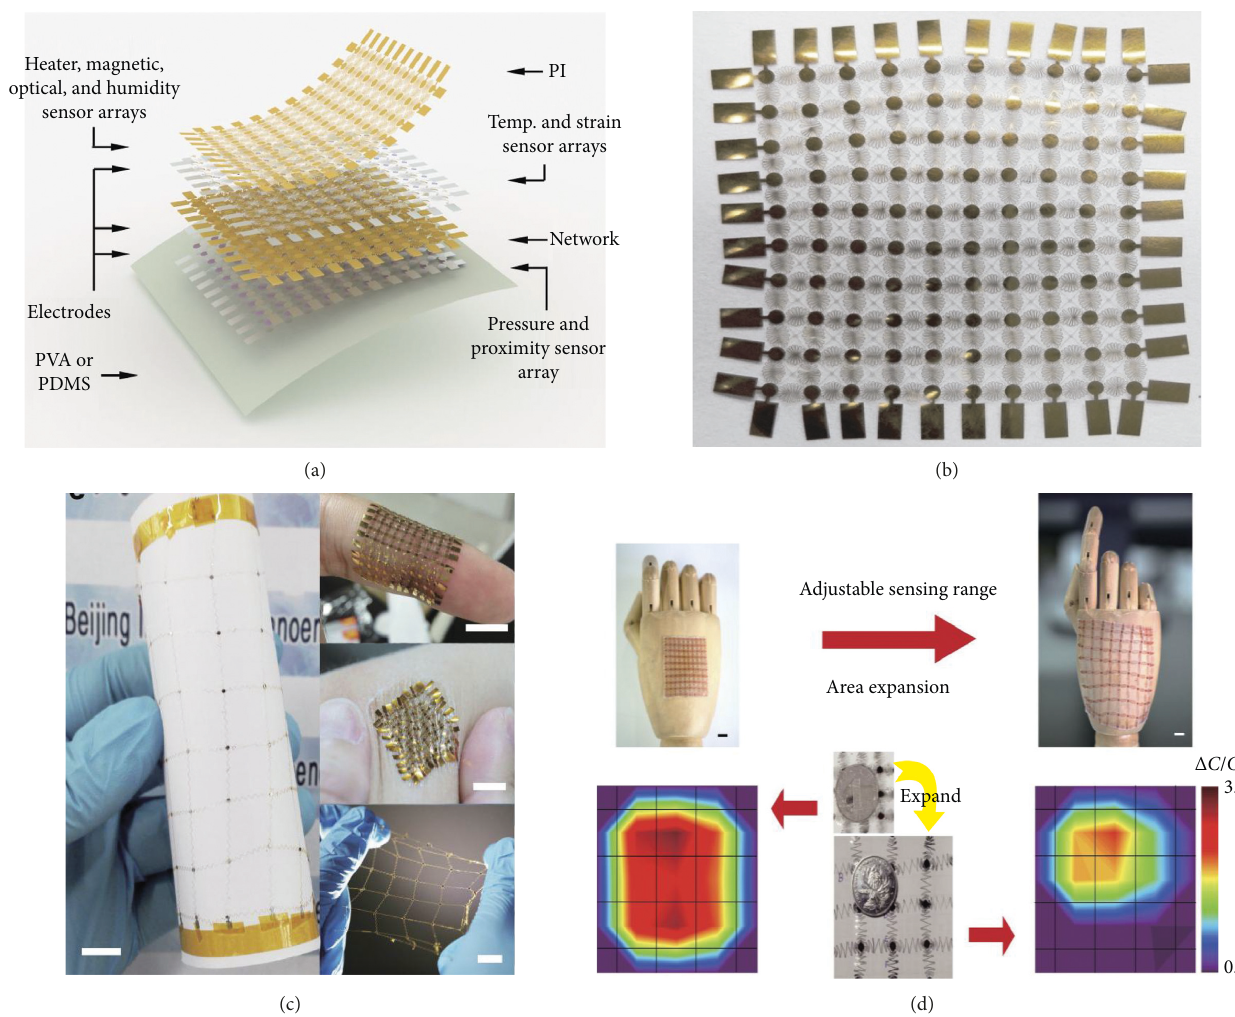
Figure 5: Schematic illustration of the skin-inspired high stretchable and conformable matrix networks. (a) Illustration showing layout of SCMNs: an integrated sensor array with eight functions; (b) photographic image indicating the fabricated polyimide network (10 × 10 array, scale bar: 5 mm); (c) schematic illustration of an SCMN as artificial skin equipped on hand (showing sensing expandability and ad- justability); (d) plot of pressure mapping before and after the 300% expansion of an SCMN (Figures 5(a)–5(d), reproduced from Ref. [93] with permission; copyright 2018; Nature publishing